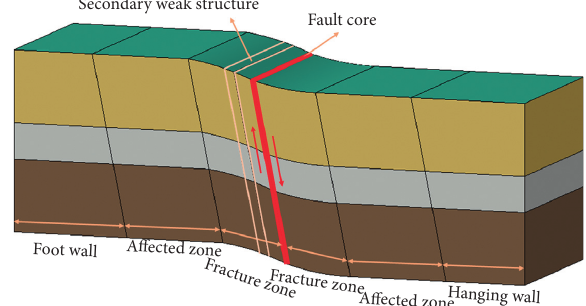
Figure 1: Geological zoning model of fault multilevel